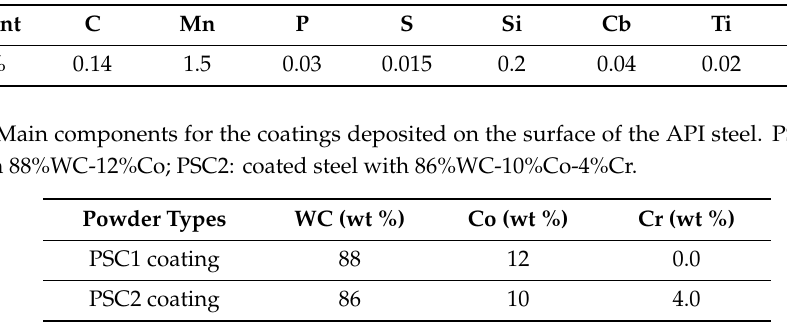
Table 1. Elemental composition for the API-2 H grade 50 steel.